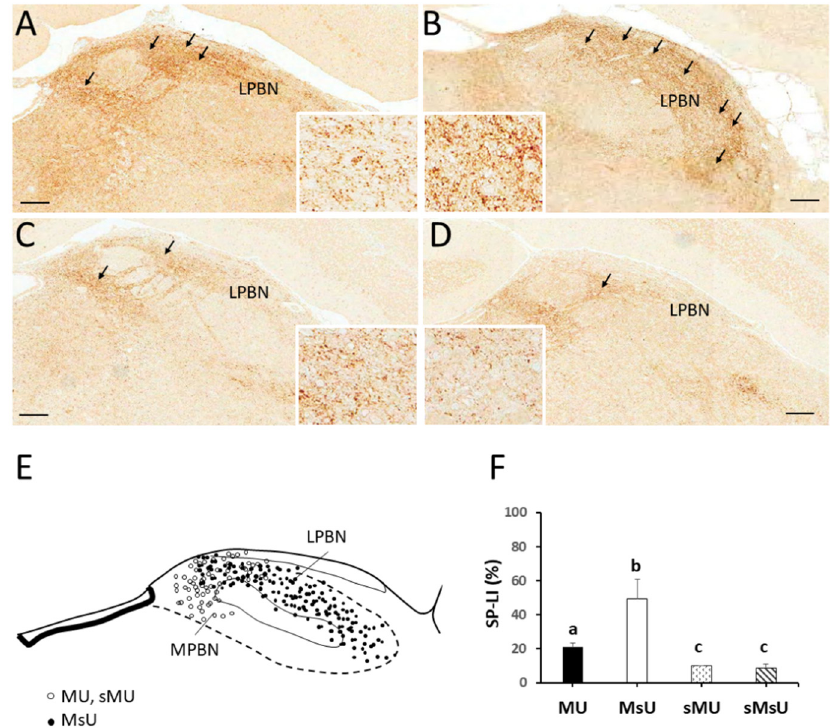
Figure 3. Representative SP-LI staining in sections of parabrachial nucleus (PBN) in rats of MU ( A ), MsU ( B ), sMU ( C ), and sMsU ( D ) groups. The distributions of SP-LI staining area are mostly located in lateral and medial parabrachial nucleus (LPBN and MPBN) in MU, sMU (solid dots), and sMU (open dots) groups ( E ). Data of SP-LI in parabrachial nucleus is presented mean ± SD and values with different superscripts (e.g., a vs. b and b vs. c) indicate significant differences ( p < 0.0083) for all possible pairwise comparisons of means tested by Mann–Whitney tests ( F ). Scale bars, 250 μ m. Table 2. The substance P (SP), μ -opiate receptors (MOR), and c-Fos immunoreactivity in the parabrachial nucleus and rostral ventromedial medulla in four groups. MU MsU sMU sMsU 1 Differences among Groups, p Value Parabrachial nucleus